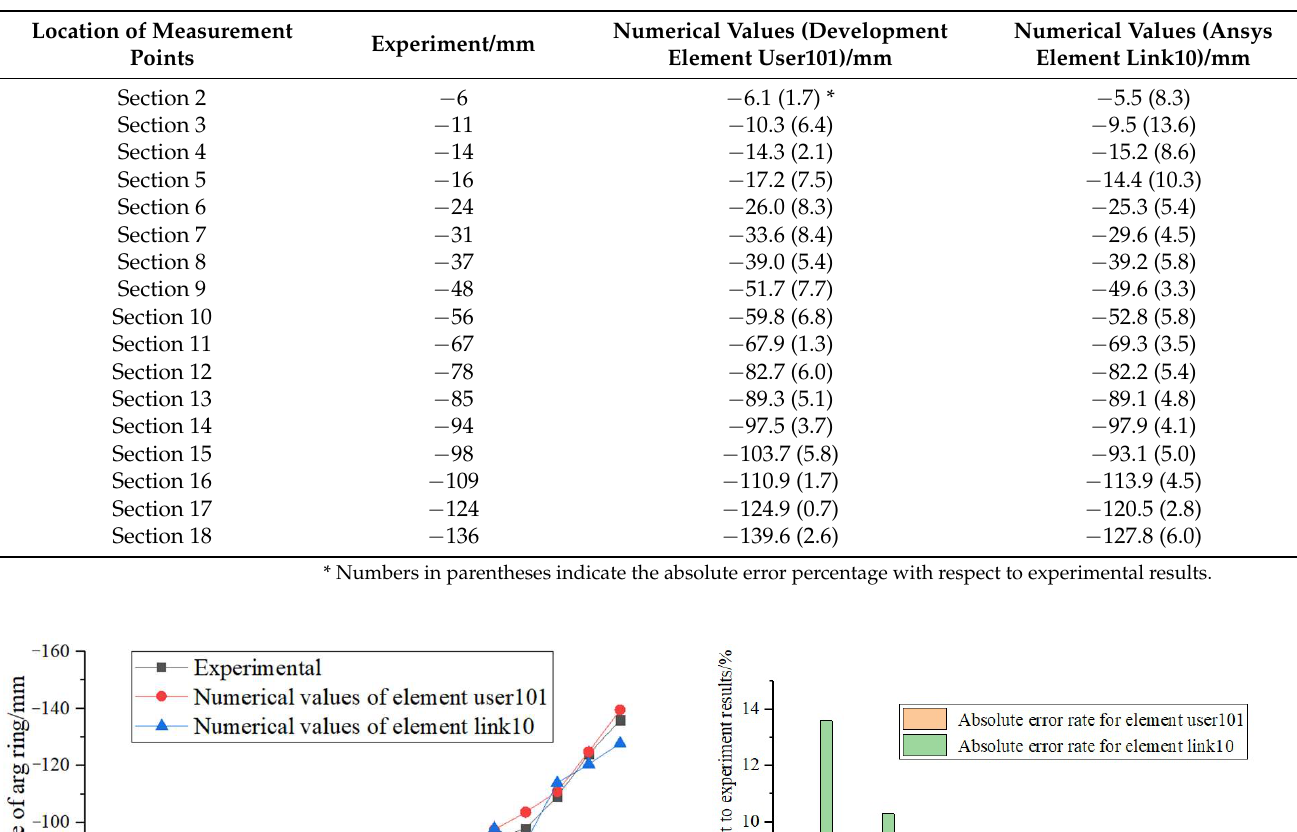
Table 7. Maximum vertical deflection of each segment of the arch ring.